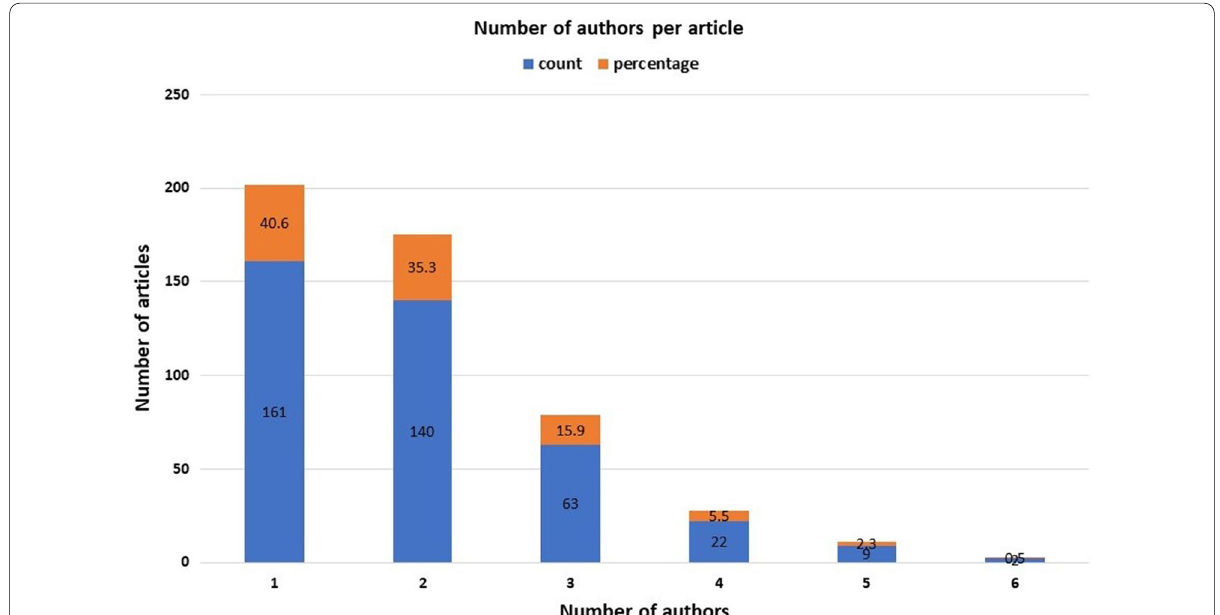
Fig. 1 Distribution of authors numbers per